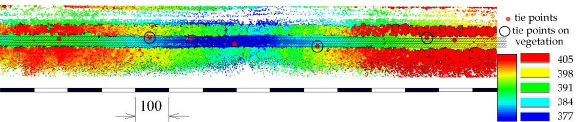
Figure 12 . The third example of MLS data with the results of searching tie points.